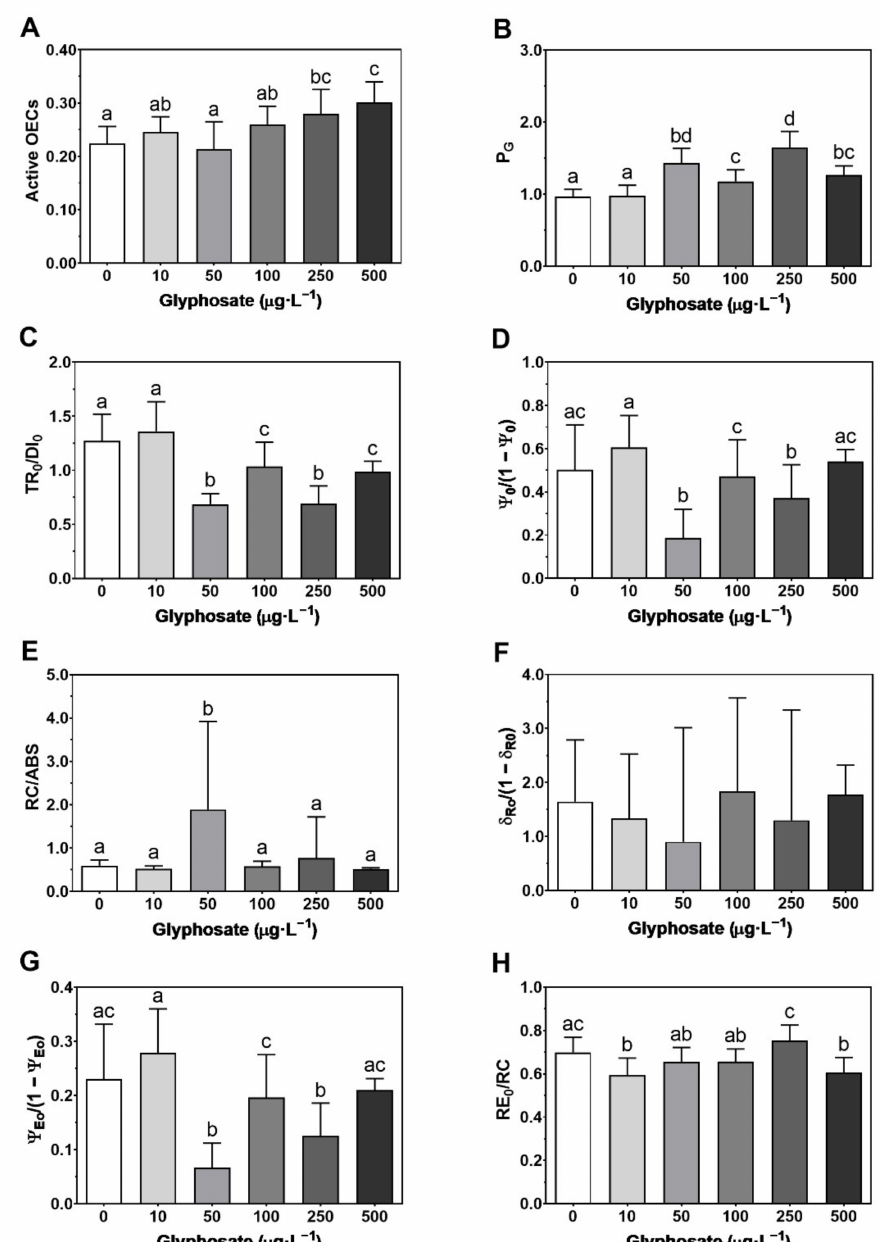
Figure 4. Photosystem II and PS I photochemical traits: ( A ) active oxygen-evolving complexes (OECs); ( B ) grouping probability between the two PSII units (P G ); ( C ) contribution or partial per- formance due to the light reactions for primary photochemistry (TR 0 /DI 0 ); ( D ) the contribution of the dark reactions from quinone A to plastoquinone ( ψ 0 /(1 − ψ 0 )); ( E ) reaction center II density within the antenna chlorophyll bed of PS II (RC/ABS); ( F ) the contribution of PSI reducing its end acceptors ( δ R0 /(1 − δ R0 ); ( G ) the equilibrium constant for the redox reactions between PS II and PS I ( ψ E0 /(1 − ψ E0 ); ( H ) electron transport from PQH 2 to the reduction of PS I end electron acceptors (RE 0 /RC)), in Ulva lactuca following a 48-h exposure to a glyphosate-based herbicide formulation in different concentrations (mean ± s.d., n = 18, different letters indicate significant differences between treatments at p <